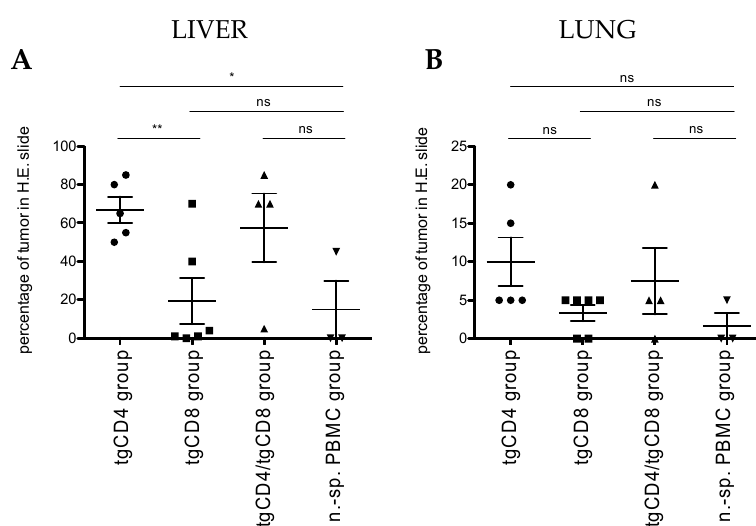
Figure 5. Control of metastatic outgrowth in a model of experimental metastasis. In vivo antitumor activity of STEAP1 130 / HLA-A*02:01-specific TCR transgenic T cells (tgCD4, tgCD8, and tgCD4 plus tgCD8 T cells - 1:1) compared to non-specific (n.-sp.) PBMC measured by control of metastatic outgrowth in liver (A) and lung (B) 30 days after tumor / therapeutic cell injection in a model of metastatic organotropism. Each dot corresponds to one animal and the percentage of tumor spread within respective organ. Error bars represent the SEM. Asterisks indicate significance levels. * p < 0.05; ** p < 0.005; *** p < 0.0005; ns = not significant.